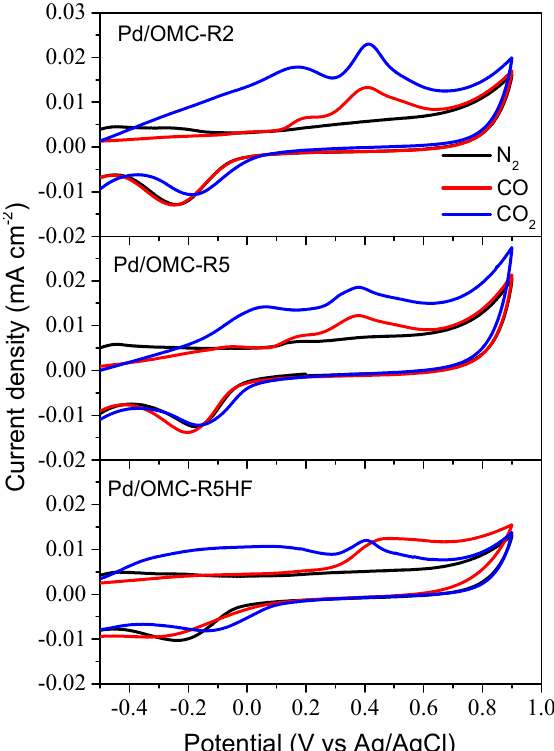
Figure 8. Comparison of CO and reduced CO 2 stripping voltammograms of Pd / OMC catalysts in 0.1 M KHCO 3 ( v = 10 mV s −1 ).